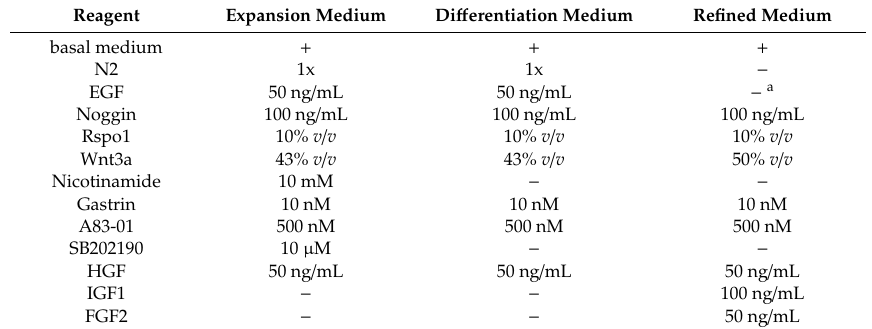
Table 1. List of media compositions used in this study. Basal medium consists of Advanced DMEM /